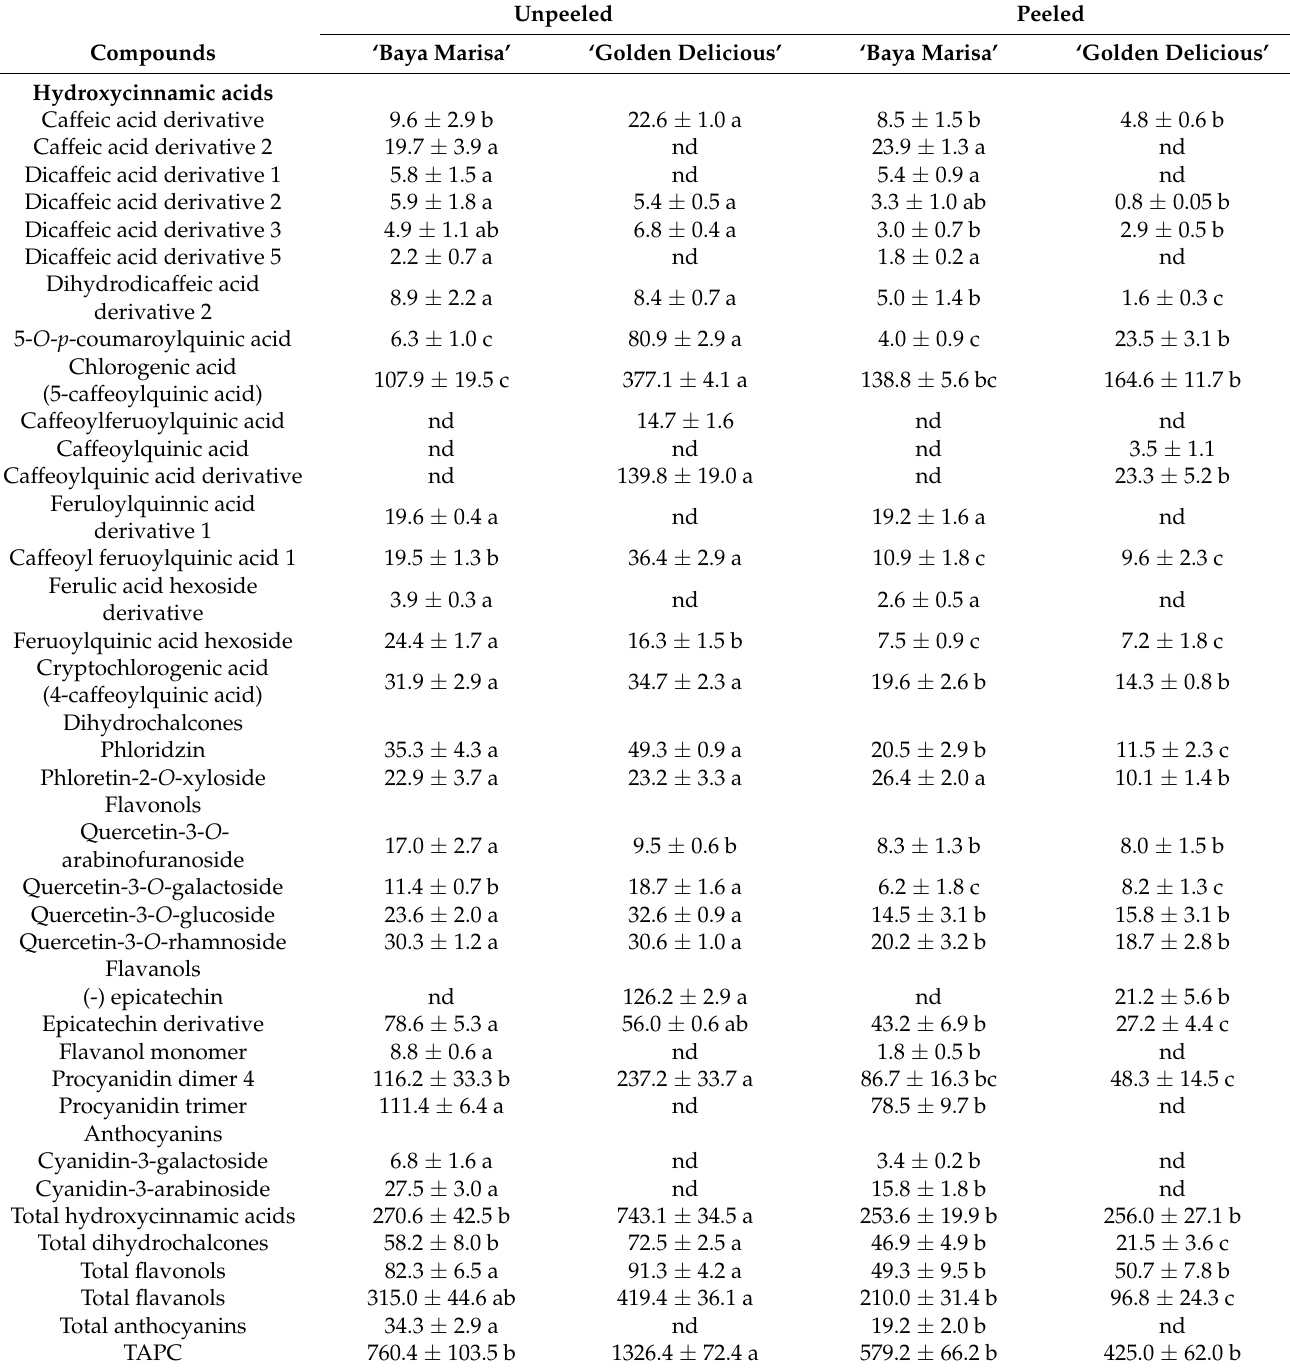
Table 3. Individual and total analyzed phenolic compounds (TAPC) in dehydrated unpeeled and peeled apple slices of the two apple ( Malus domestica Borkh.) cultivars ‘Baya Marisa’ and ‘Golden Delicious’ (mean ± SE, in mg/kg